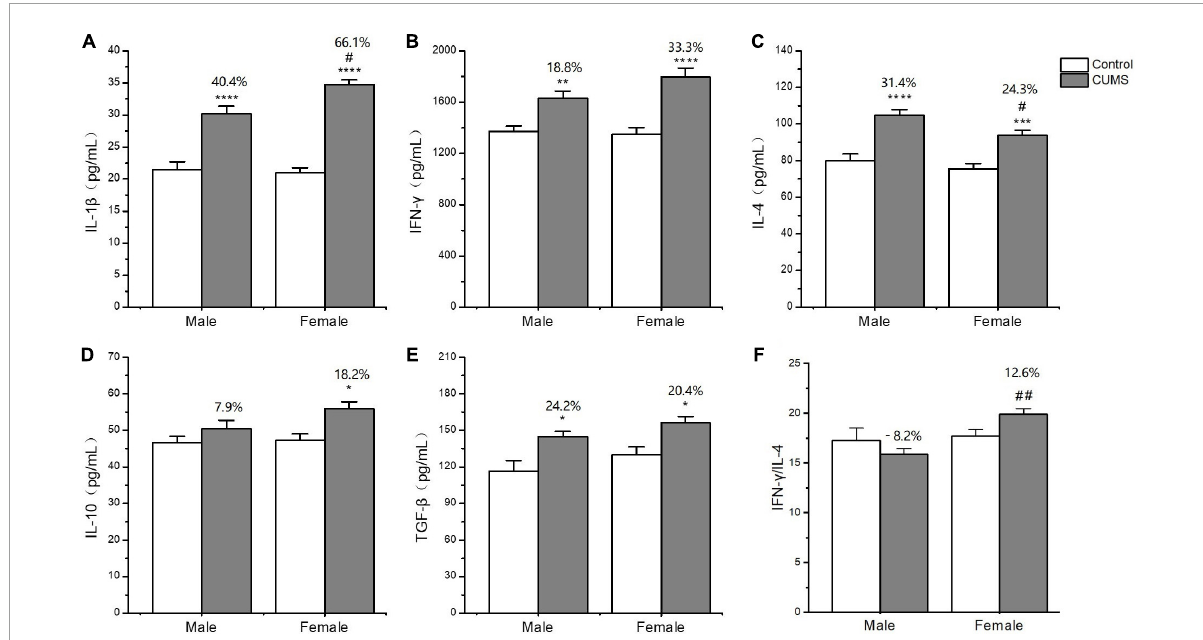
FIGURE7 The changes of inflammation cytokines in serum of male and female rats. (A–F) The concentrations of inflammation cytokines of IL-1 β , IFN- γ , IL-4, IL-10, and TGF- β , and the ratio of IFN- γ /IL-4 in serum. * p < 0.05, ** p < 0.01, *** p < 0.001, and **** p < 0.0001 vs. control with same sex, # p < 0.05, ## p < 0.01 vs. male stress